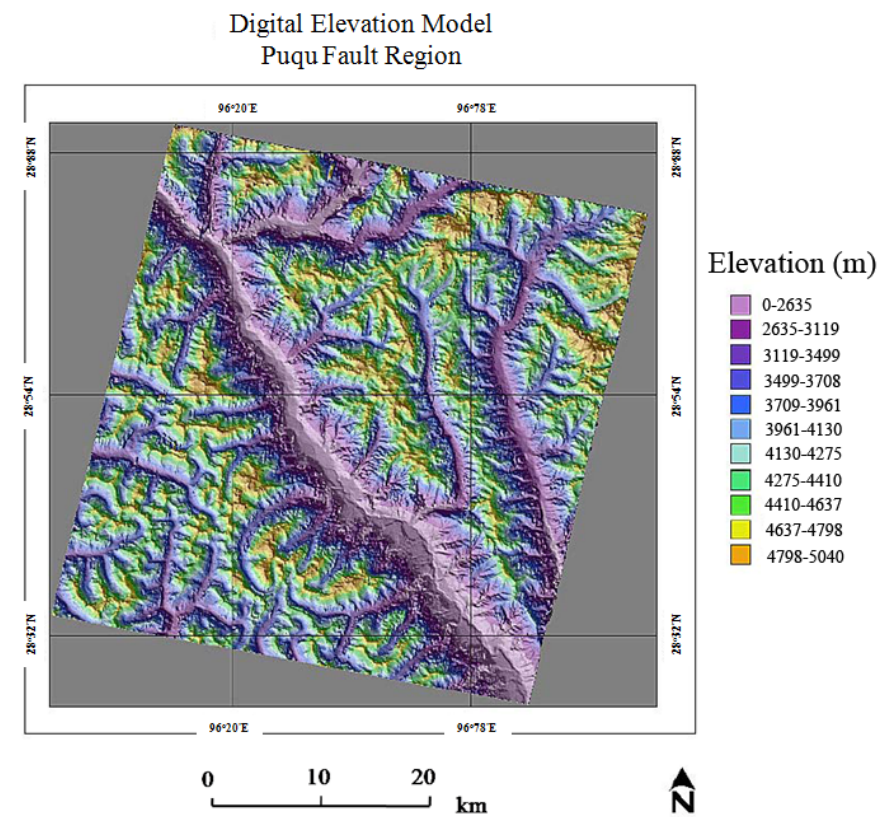
Figure 4. The digital elevation model (DEM) derived from the ASTER stereo pair images for the Puqu Fault region.